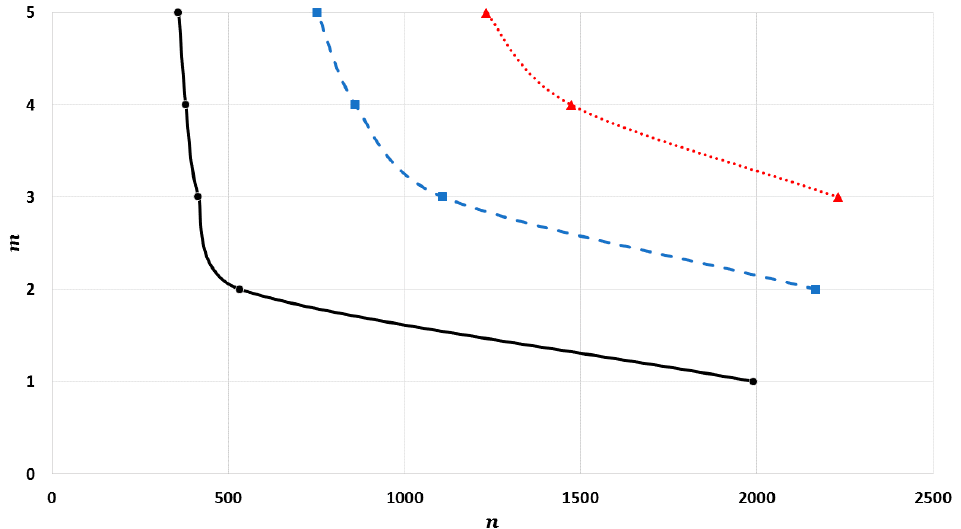
Figure 11. The variation of m with the number of atoms n for nanoparticles, having relative cohesive energies of approximately 0.686, and di ff erent values of α : 3.1 (black solid line and circles), 2.1 (blue dashed line and squares), and 2.4 (red dotted line and triangles).